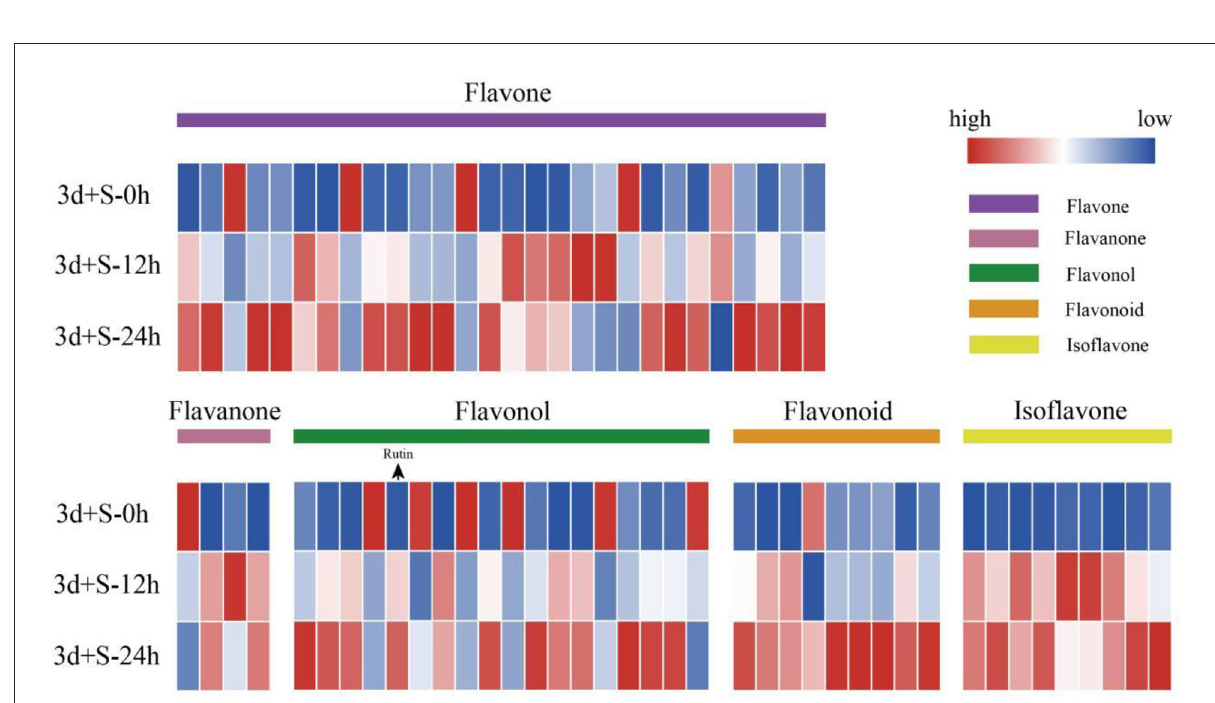
FIGURE4 The heatmap of differentially altered metabolites associated with flavonoids. Different colored modules on the heatmap represent different types of flavonoids, while the order from top to bottom is 3d + S-0h, 3d + S-12h, and 3d + S-24h. Blue to red color represents expression from low to